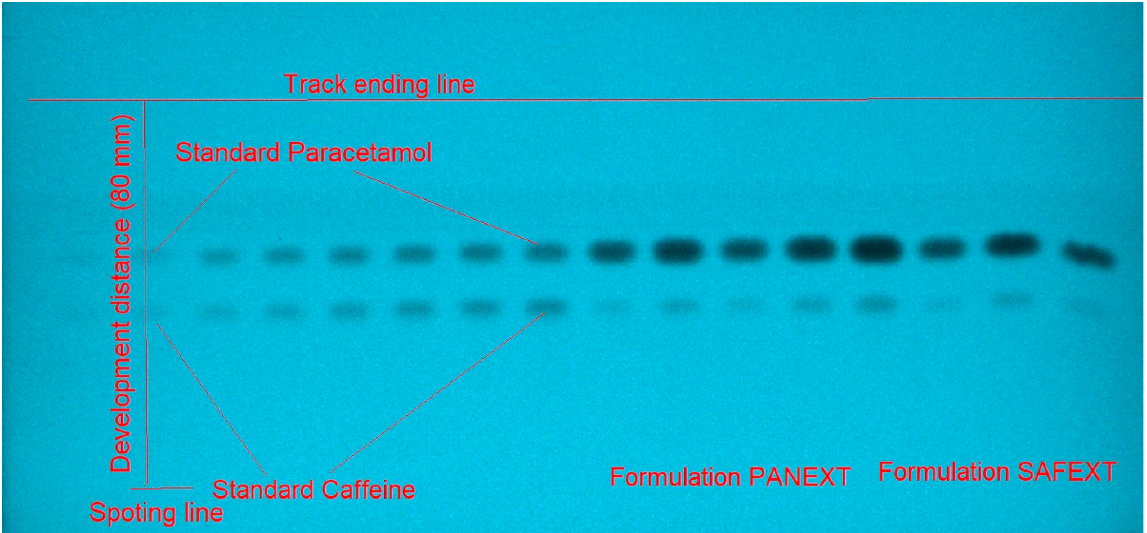
Figure 3. Developed thin ‐ layer chromatography (TLC) plate for standard caffeine, standard parace ‐ tamol, commercial tablets PANEXT, and commercial tablets SAFEXT developed using ethanol (E)/water (W) (50:50 v / v ) as the greener mobile phase for the greener reversed ‐ phase HPTLC method.